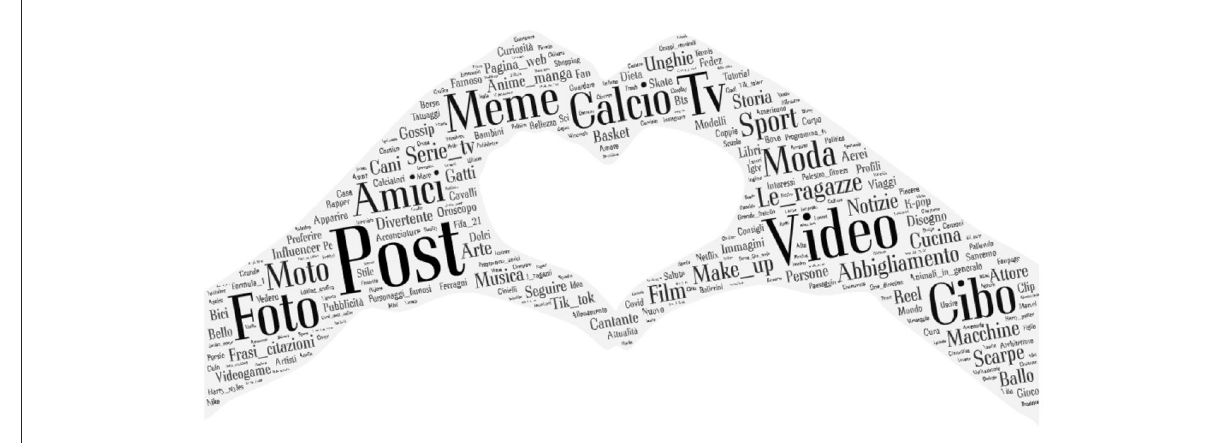
FIGURE2 The instagram “browse tab”: keyword